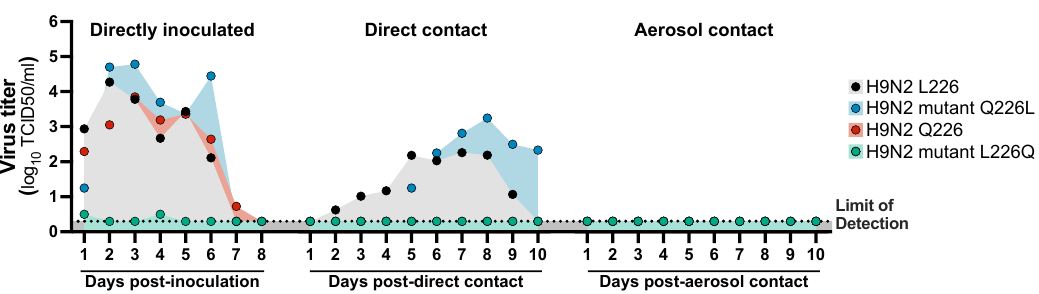
Figure 1. Impact of position 226 in the H9 of H9N2 IAVs. ( A ) The 3D molecular structure of the H9 HA glycoprotein globular head from A/Guinea Fowl/Hong Kong/WF10/99 (WF10) with glutamine (Q) or leucine (L) in position 226. The sialic acid binding pockets are shown in each case (amino acid residues shown in yellow and cyan) with bound sialic acid, shown in gray and red. Structure constructed using the iTASSER structure prediction tool [80]. ( B ) The different residues in position 226 of the H9 were analyzed from H9N2 IAVs isolated for avian species, humans, swine, and other mammals (canine, equine, and mink). Full H9 sequences were downloaded from the Global Initiative on Sharing All Influenza Data (GISAID). Sequence analyses were performed using Geneious Prime 2020.2.4 (https://www.geneious.com, accessed on 19 May 2021). ( C ) Summary of the replication, transmission by direct contact or airborne transmission in ferrets inoculated with H9N2 IAVs viruses carrying L226 (H9N2 L226) or Q226 (H9N2 Q226) in the H9. Data for replication and transmission of mutant viruses with H9 Q226L (H9 mutant Q226L) or H9 L226Q (H9N2 mutant L226Q) are also shown. Results compiled from